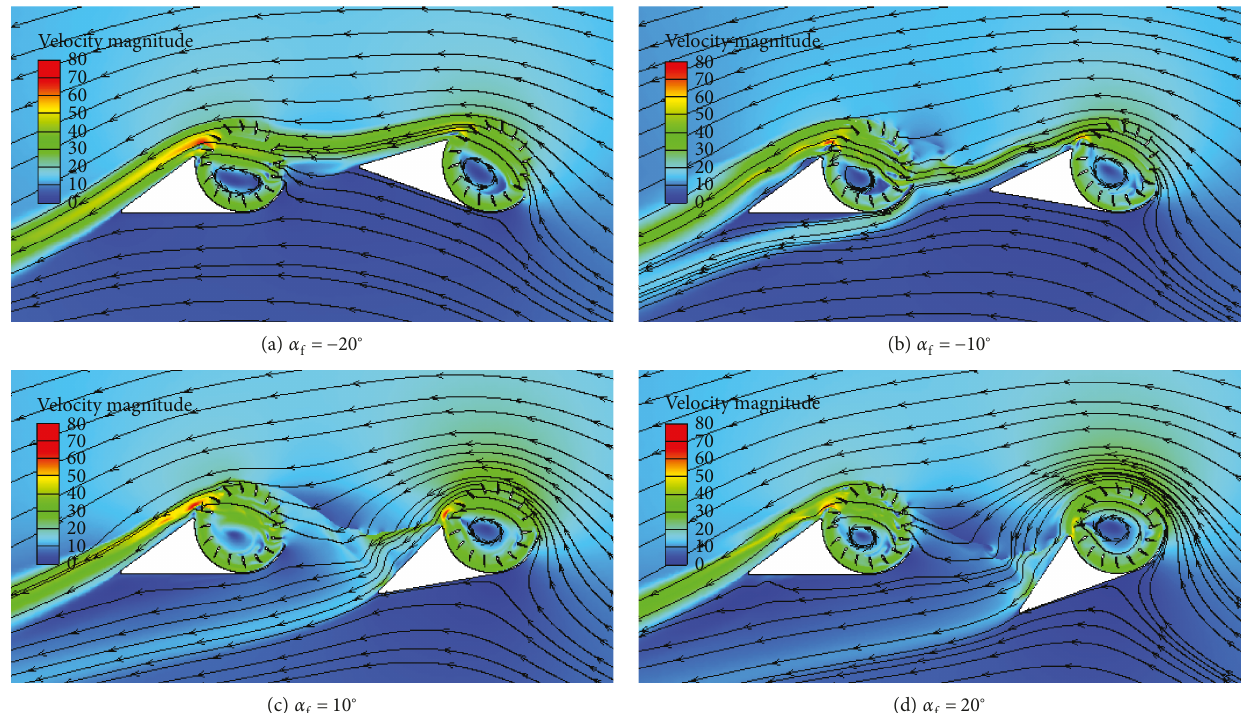
Figure 15: Velocity contours and streamlines of the lift and thrust of the front and rear fan wings when the rear wing is fi xed.